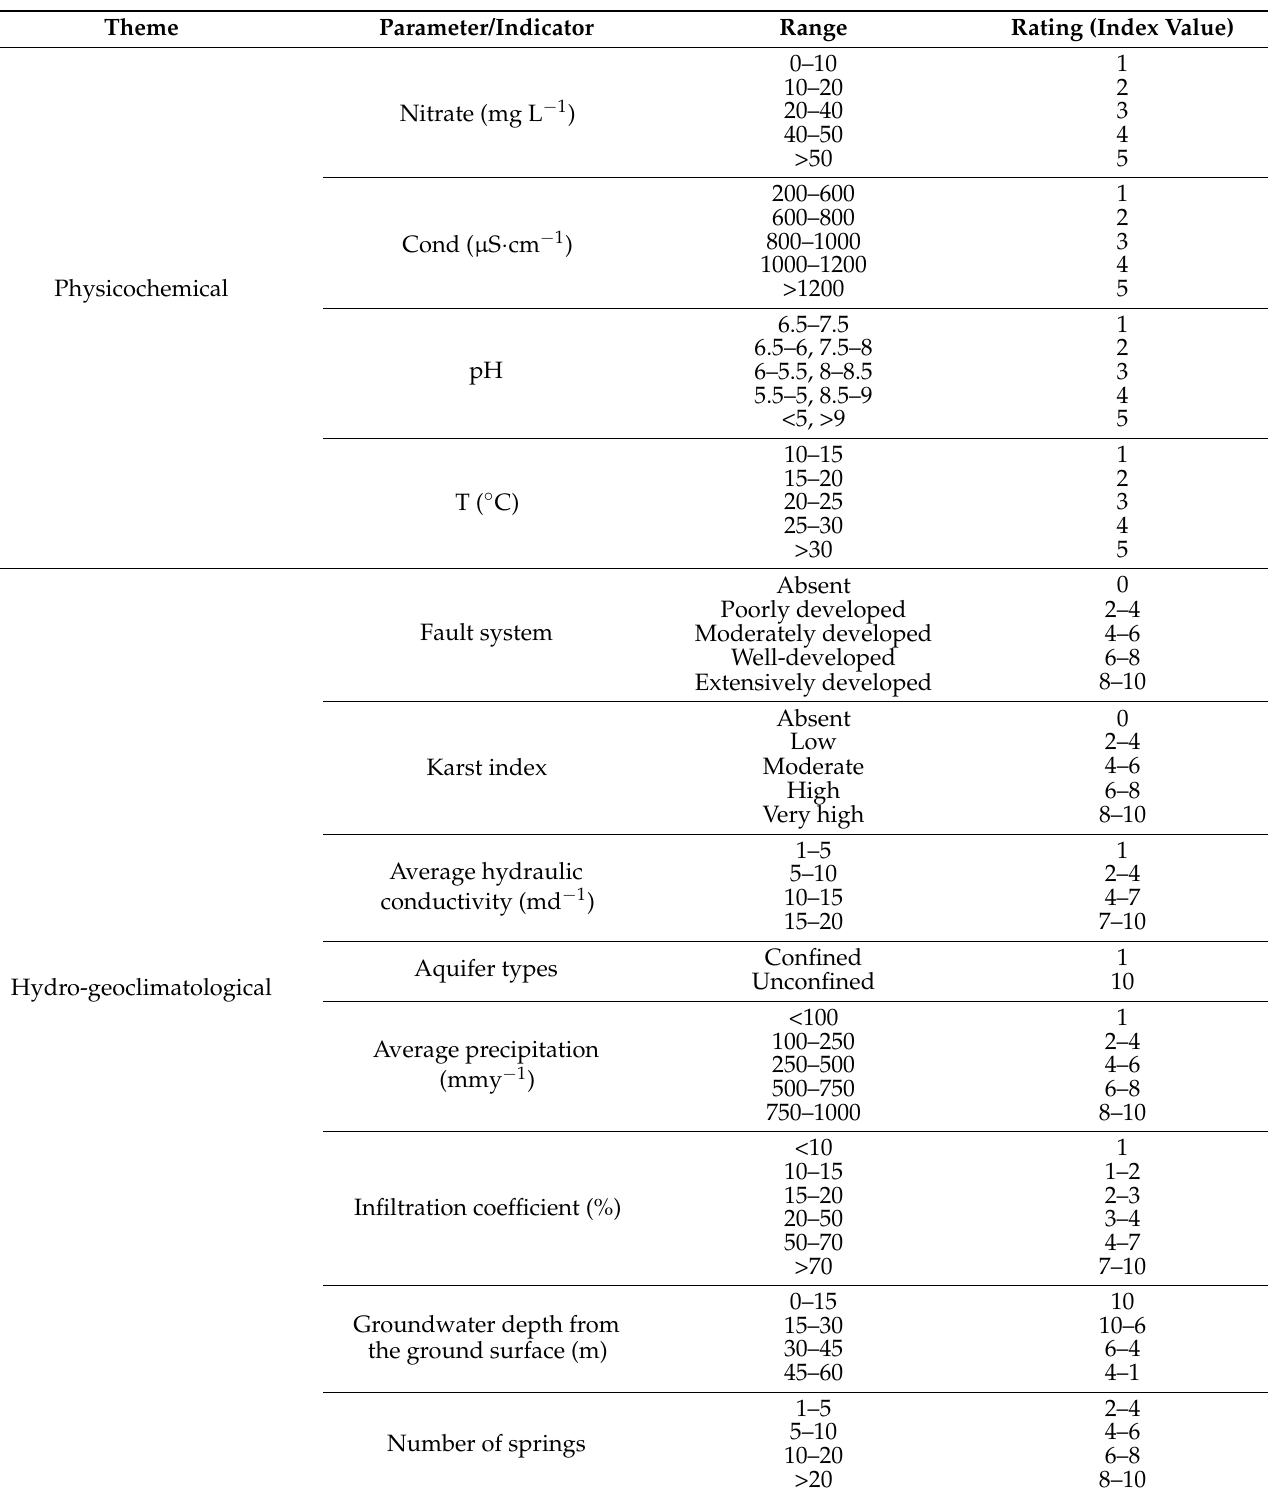
Table 1. A proposed grading system (range and rating) designed for this